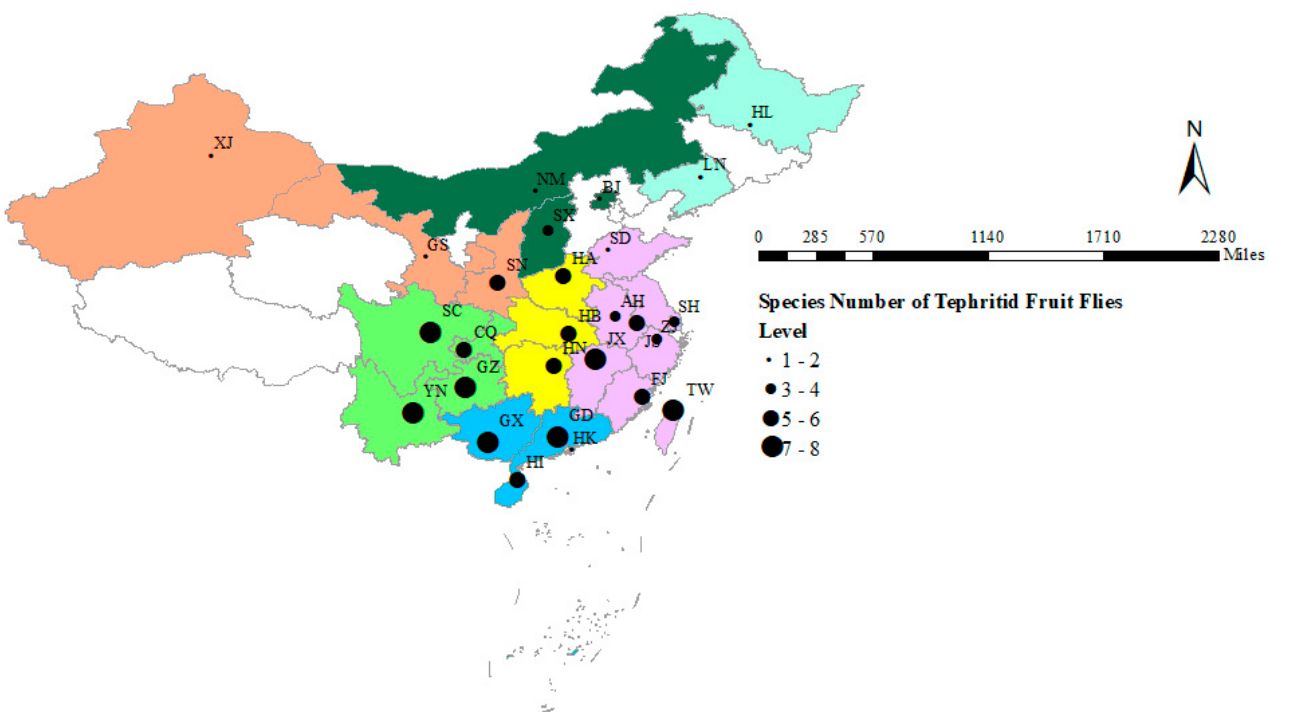
Figure 1. Distribution of tephritid fruit flies in each province of China. The size of the solid circles in the figure represents the species number of tephritid fruit flies. Colors in the figure represent different regions. Abbreviations: AH, Anhui; BJ, Beijing; CQ, Chongqing Shi; FJ, Fujian; GS, Gansu; GD, Guangdong; GX, Guangxi Zhuangzu Zizhiqu; GZ, Guizhou; HA, Henan; HB, Hubei; HI, Hainan; HK, Hong Kong; HL, Heilongjiang; HN, Hunan; JS, Jiangsu; JX Jiangxi; LN, Liaoning; NM, Nei Mongol Zizhiqu; SC, Sichuan; SD, Shandong; SH, Shanghai Shi; SN, Shaanxi, SX, Shanxi; XJ Xinjiang Uygur Zizhiqu, TW, Taiwan; YN, Yunnan; ZJ, Zhejiang. The map data was generated by Geospatial Data Cloud (https://www.gscloud.cn, accessed on 4 February 2022) and Alibaba Cloud (DataV.GeoAtlas, http://datav.aliyun.com/portal/school/atlas/area_selector, accessed on 4 February 2022). The spatial analysis function was via ArcGIS (version 10.7) and Mapshaper (https://mapshaper.org, accessed on 4 February 2022). Table 1. Distribution of tephritid fruit flies (Diptera: Tephritidae) in China (based on the provincial level).